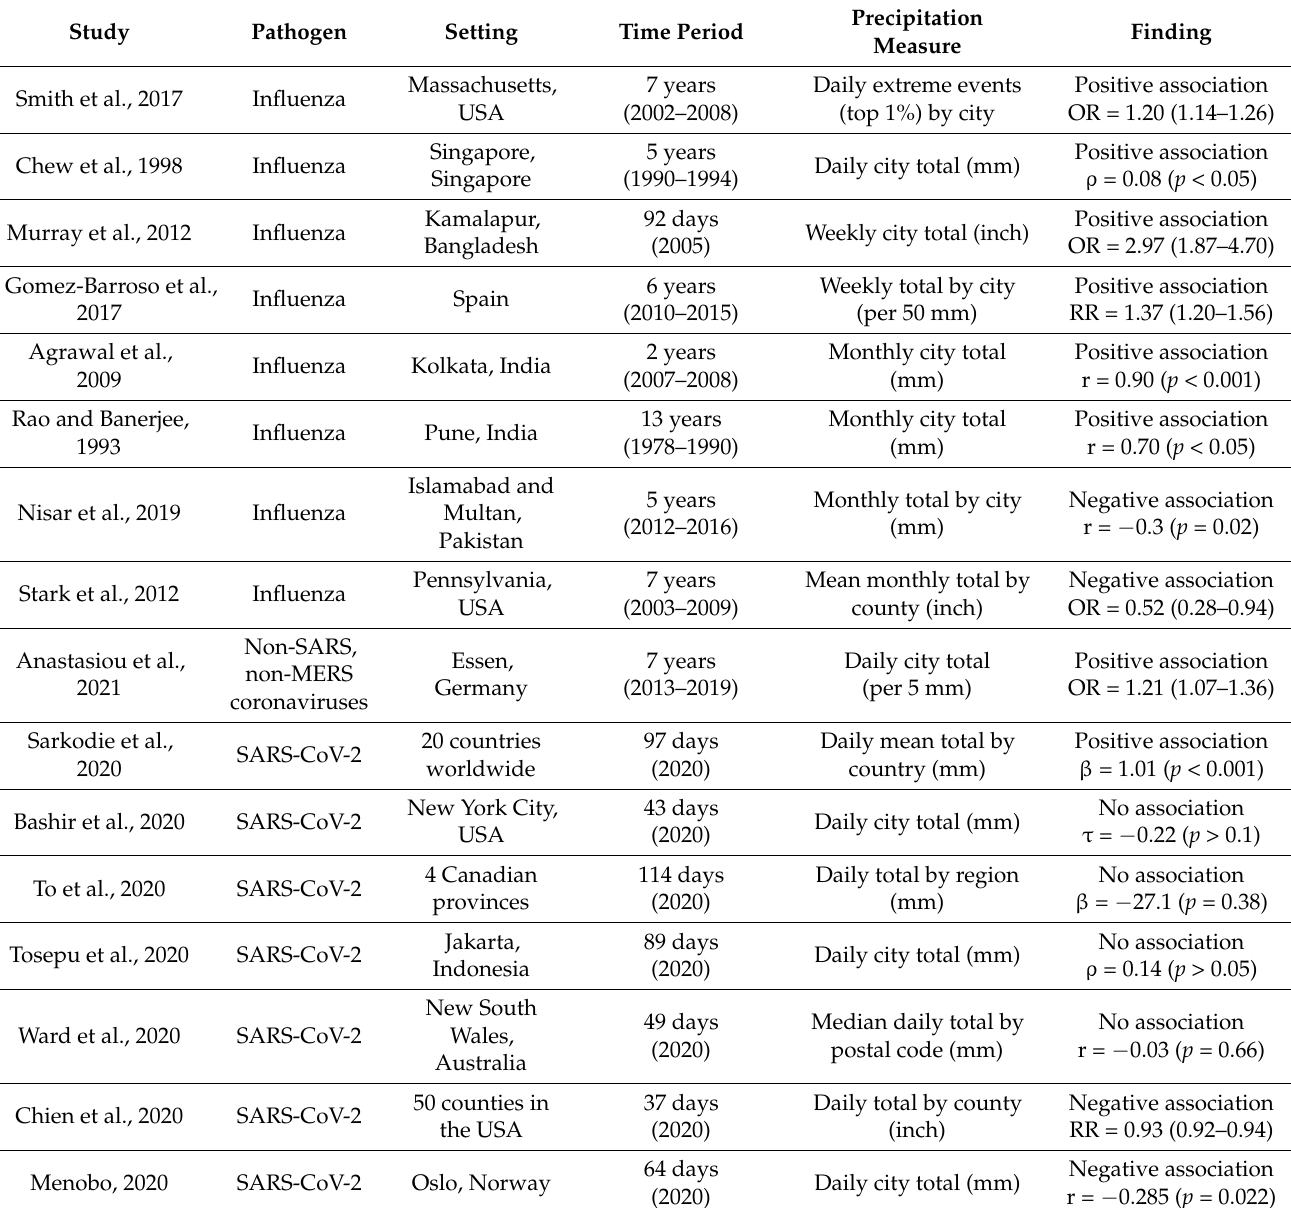
Table 1. Review of published literature investigating the association between precipitation and respiratory virus infection. All measures of association represent an association between incident cases of the pathogen with the specific precipitation measure under study. 95% confidence intervals are provided in parentheses after ratio estimates. Studies are organized by (1) pathogen, (2) precipitation measure, then (3)